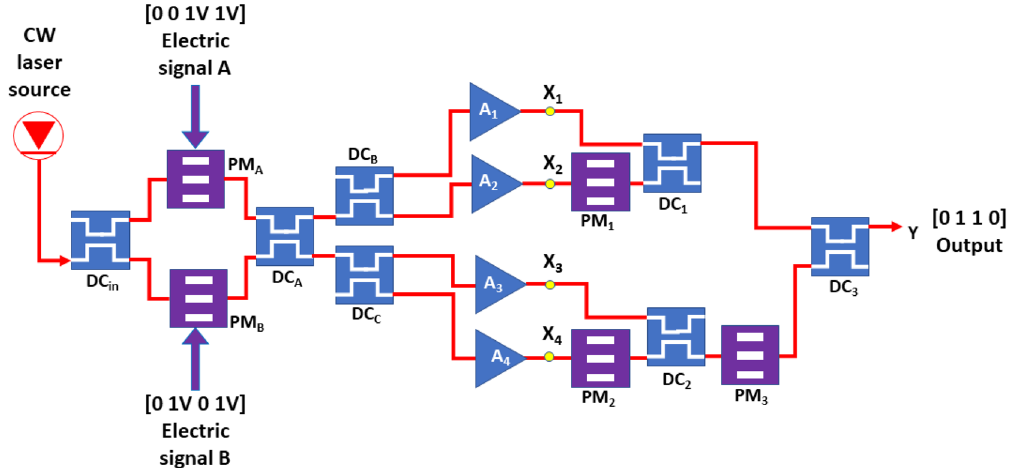
Figure 1. The optical setup of this EO logic gate. CW, DC and PM stand for the continuous wave, the 2 by 2 directional coupler, and the phase modulator. The possible recombination of the input signals A and B is (0, 0), (0, 1 V), (1 V, 0) and (1 V, 1 V). The corresponding Y target for the XOR gate is [0 1 1